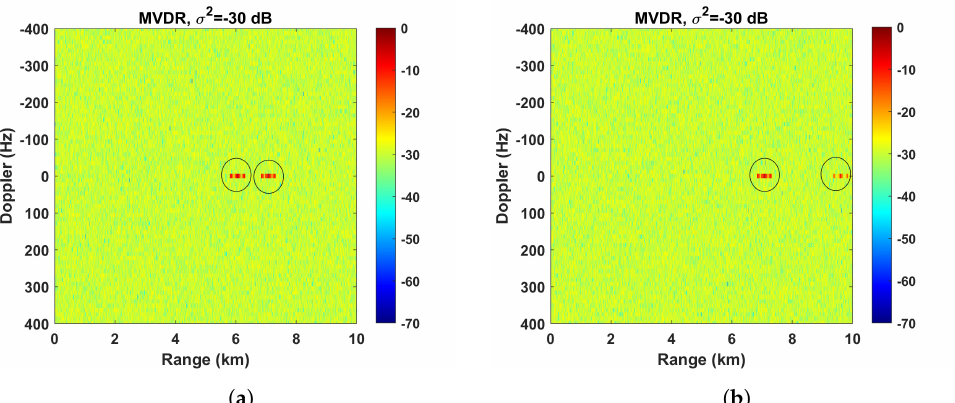
Figure 8. Range–Doppler map applying the MVDR beamforming technique after the CAF where the interference signals are not removed correctly: ( a ) target #1 is not removed; ( b ) target #3 is not